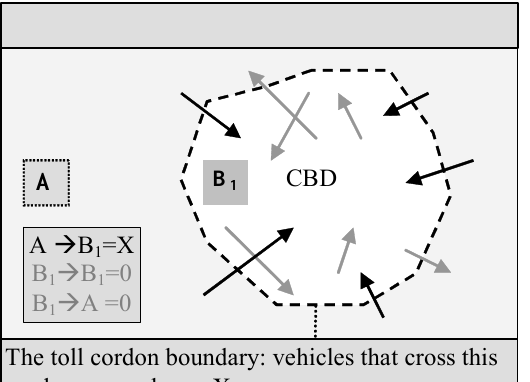
Figure 1. Cordon Charging